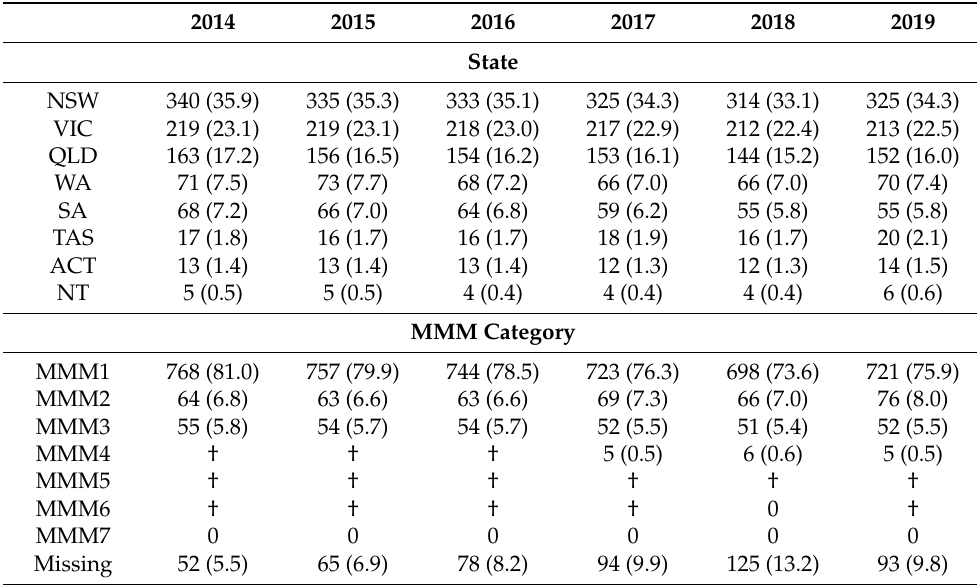
Table 2. Australian state or territory and MMM category by year ( n = 948).